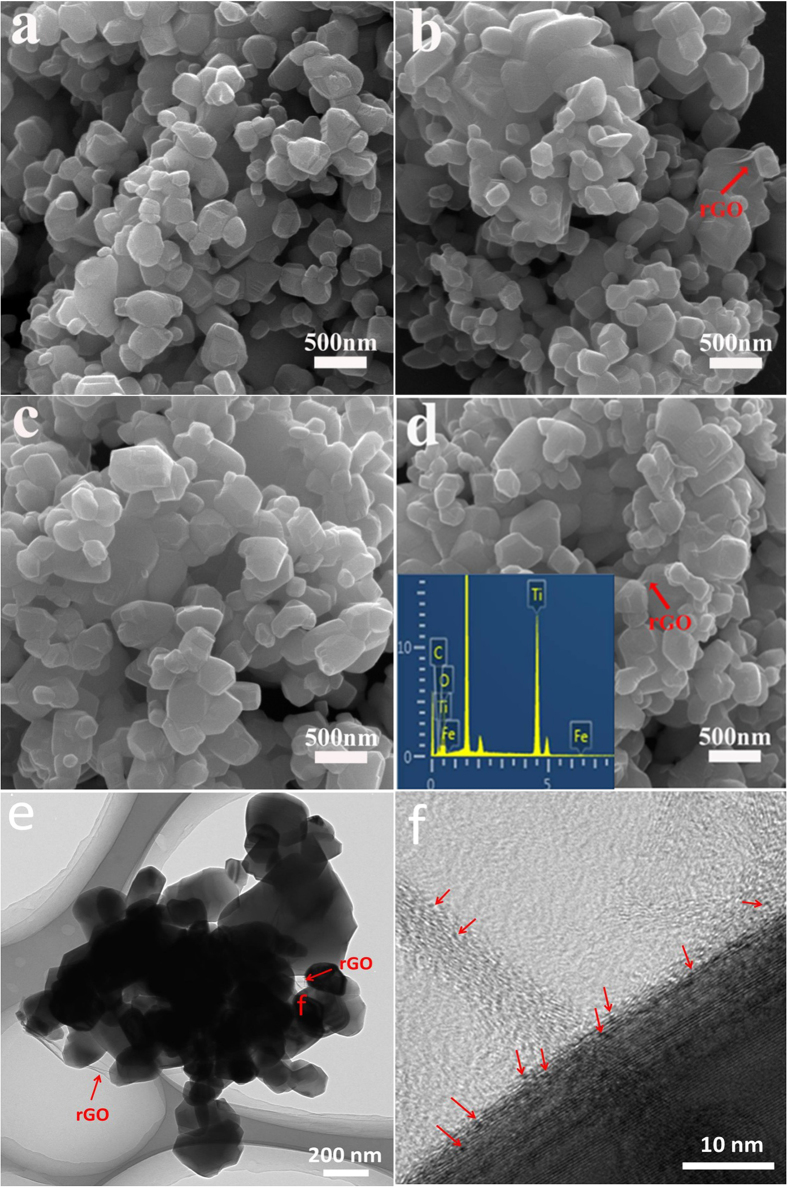
FESEM images of (a) TiO2; (b) rGO-TiO2; (c) Fe(III)/TiO2; (d) Fe(III)/rGO-TiO2. TEM (e) and HRTEM (f) images of Fe(III)/rGO-TiO2 photocatalyst: the red arrows in (e) and (f) showing the rGO and Fe(III) clusters, respectively.